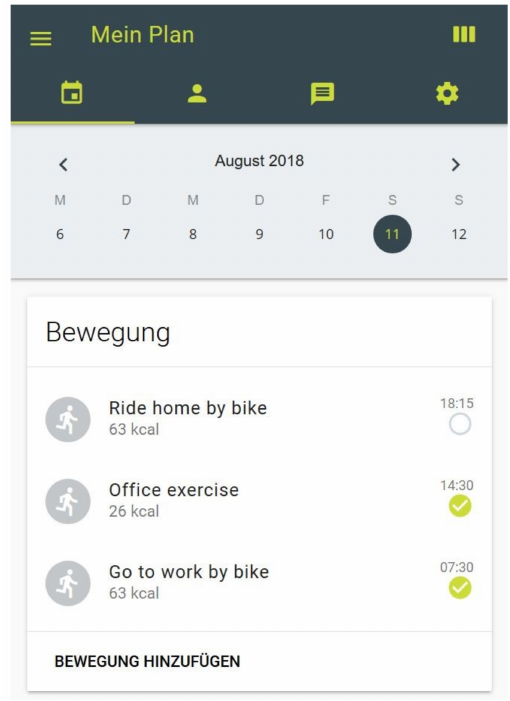
Figure 2. Plan page of activity profile on